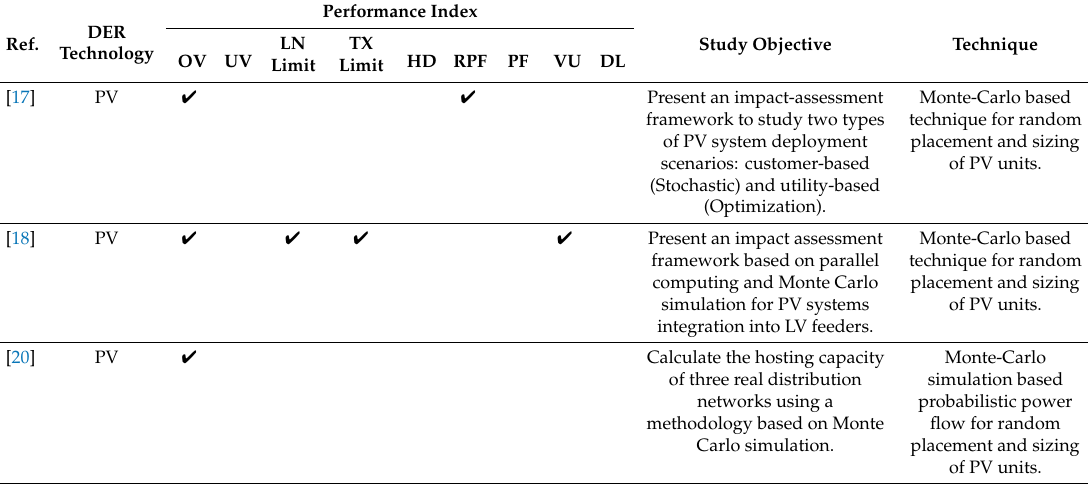
Table 3. Studies that utilize the stochastic method for hosting capacity evaluation.